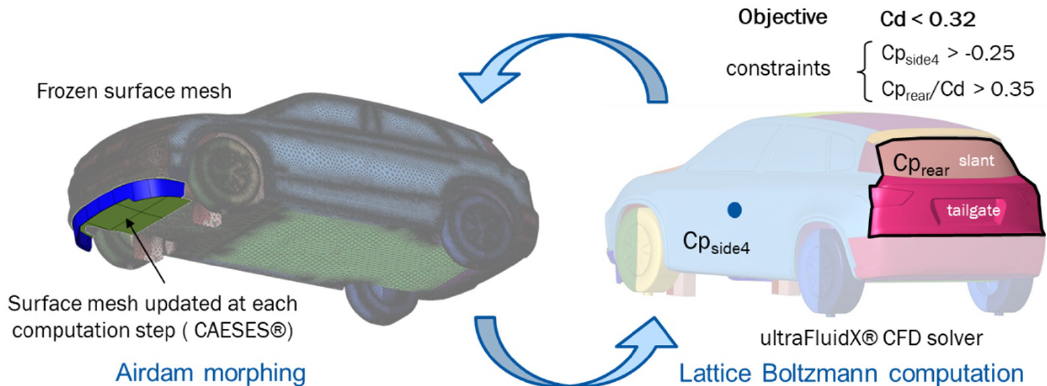
Figure 10. Design space exploration with Sobol sequence of the morphed air dam geometry, with objective and constraints values.